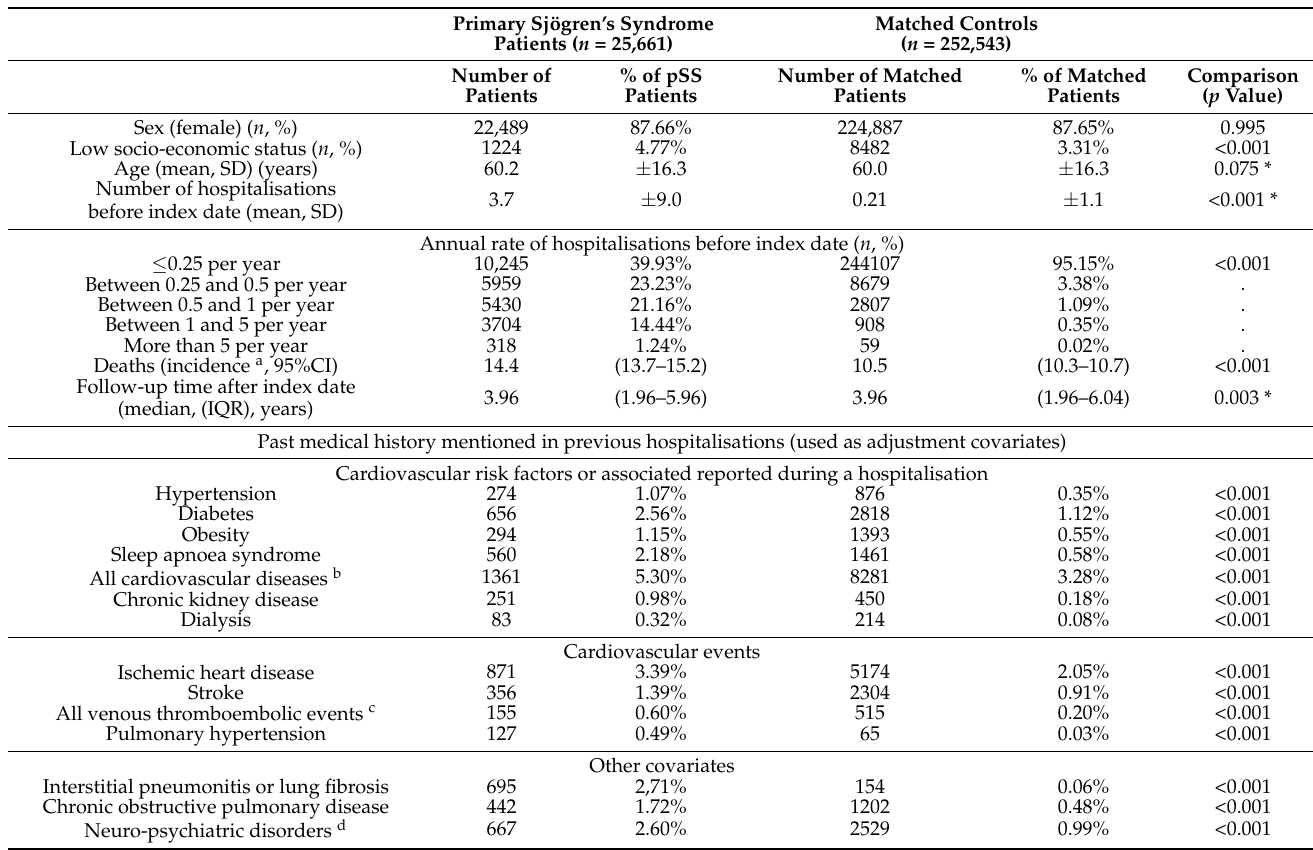
Table 1. Demographical and social characteristics of hospitalised primary Sjögren’s syndrome patients and controls and adjustment